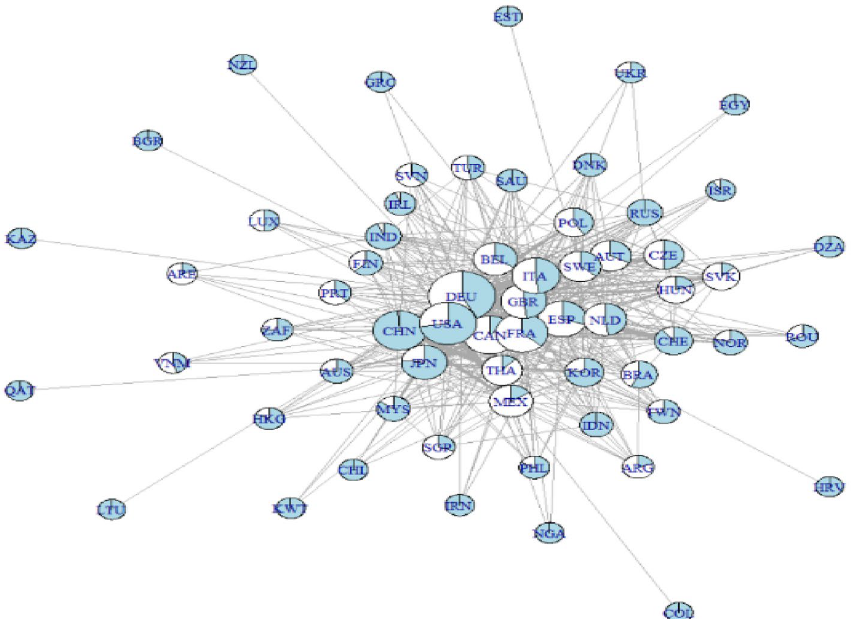
Fig. 1 Value-added contribution in Transport Equipment Network. The node area reflects the total flows of value-added in or out of the industry, with relative proportion of in- and out-flows indicated in blue and white, respectively. Edges’ width reflects the volume of flows from the origin and destination. The Large Graph layout was used to produce this graph (Source: Own elaboration with EORA